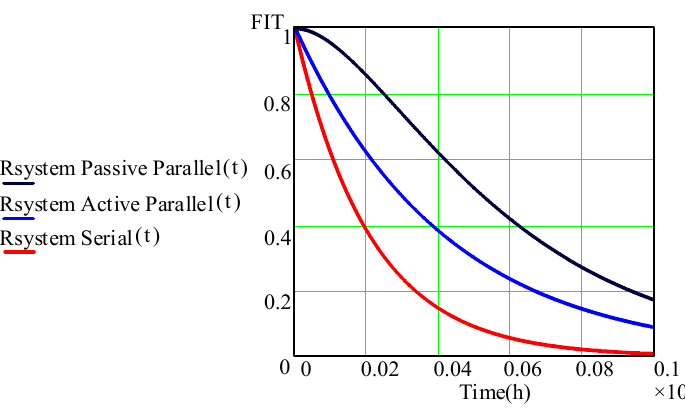
Figure 7. Reliability comparison of the di ff erent structures.